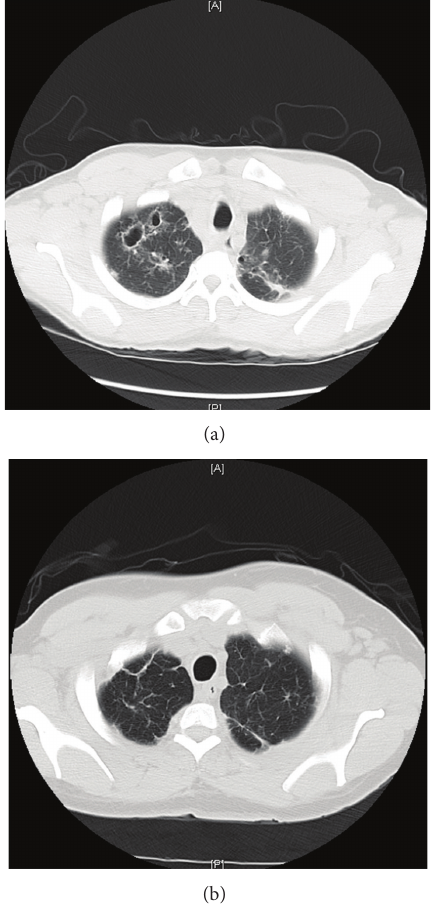
Figure 1: (a) CT scan of chest revealing cavitary lesions. (b) CT scan of chest shows resolution of cavitary